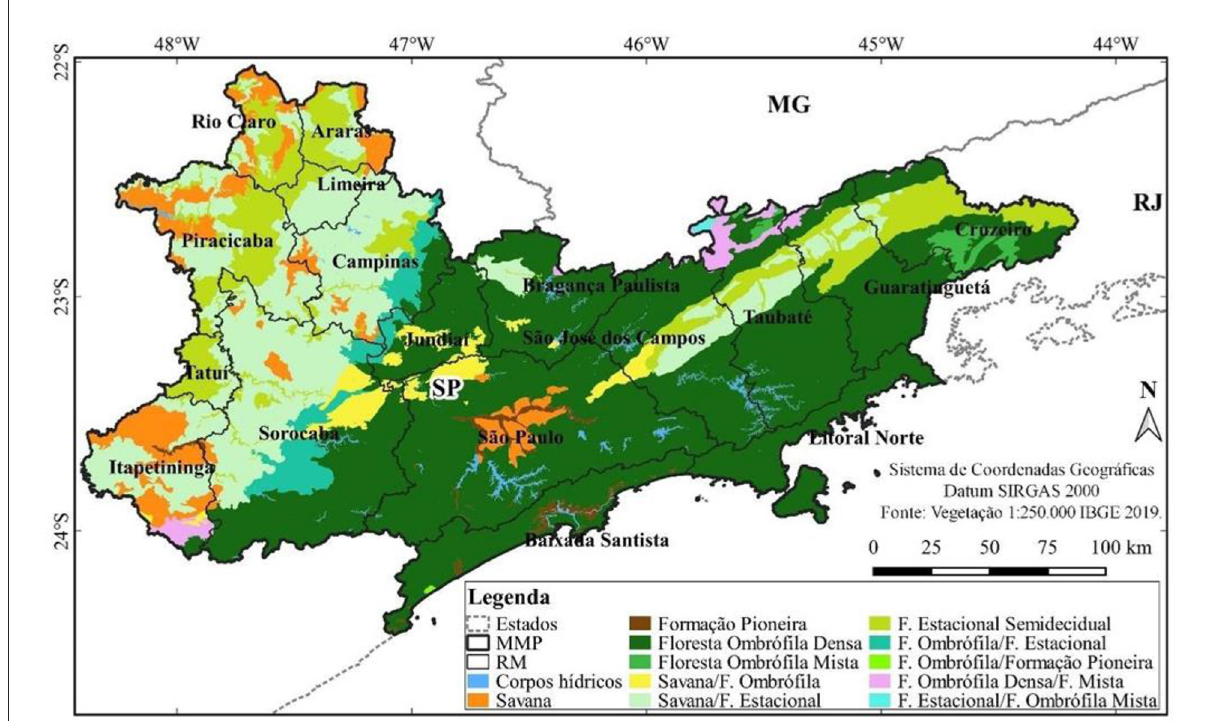
FIGURE3 Original natural coverage of the area today occupied by the Paulista Macrometropolis. Source: Vegetation 1:250,000, version 2019 (IBGE, 2019), available in MapBiomas (mapbiomas.org), cited from Bueno Machado and Dias de Freitas